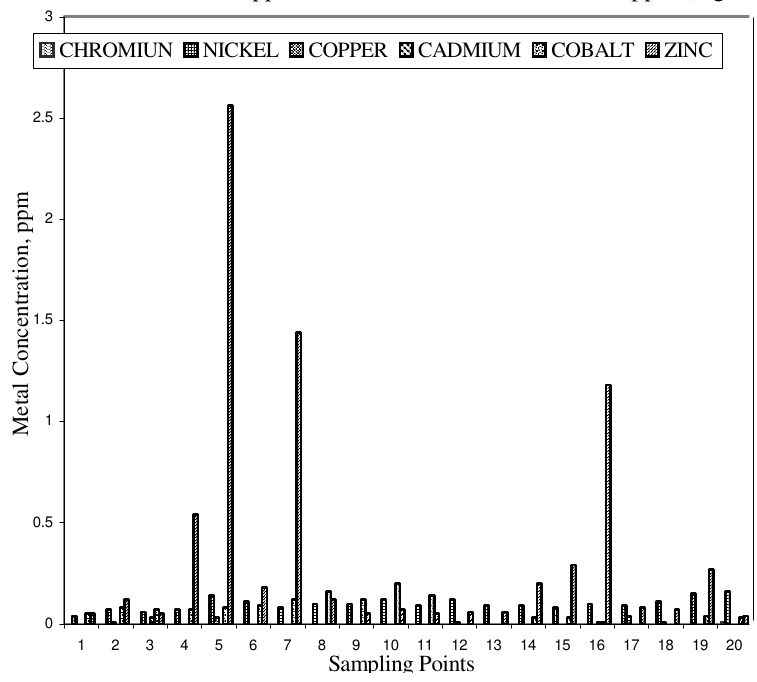
Figure 6. Heavy Metal content (ppm) in various groundwater samples of